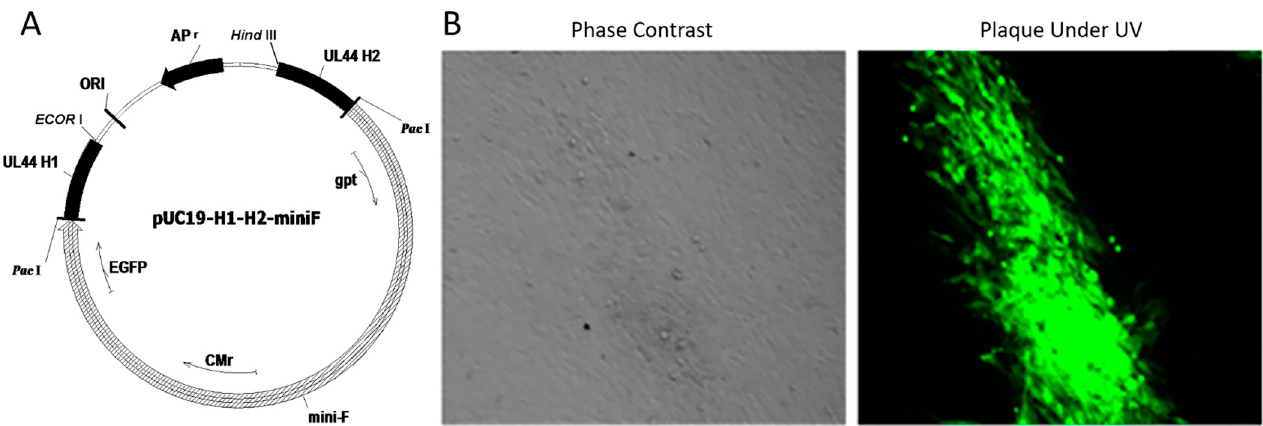
Figure 2. pUC19-H1-H2-miniF and plaques of HVT-miniF: ( A ): Predicted map of the transfer vector pUC19-H1-H2-miniF containing the homologous fragments flanking the gC site. ( B ): A plaque phase contrast is shown under no-UV excitation in the left panel, and plaque phase under UV excitation is shown in the right panel (Green).